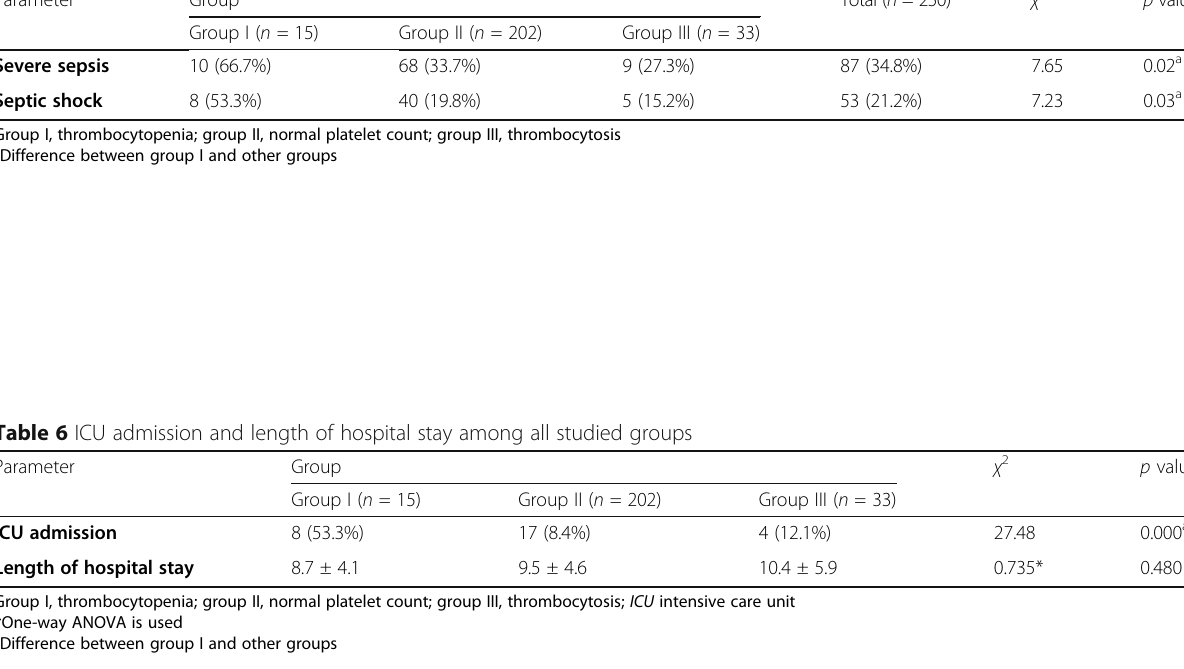
Table 5 Distribution of severe sepsis and septic shock among all studied groups Parameter Group Total ( n = 250) χ 2 Group I ( n = 15) Group II ( n = 202) Group III ( n = 33) Severe sepsis 10 (66.7%)